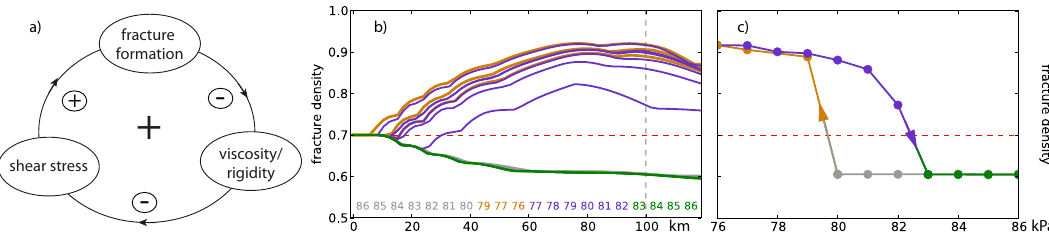
Fig. 7. The self-amplifying feedback (a) is studied in a simplified ice-shelf setup for successively varied fracture-initiation threshold σ cr . Corresponding steady-state fracture-density profiles along the flow line are shown in rainbow colors (b) . Each profile initiates at the point of prescribed value φ = 0 . 7 at the left hand side. Fracture density accumulates or decays with distance from this point depending on the specific threshold. The black vertical line indicates the position 100km downstream, where values are taken for hysteresis plot (c) . Two steady-state fracture densities exist between 79kPa and 83kPa depending on the previously evaluated